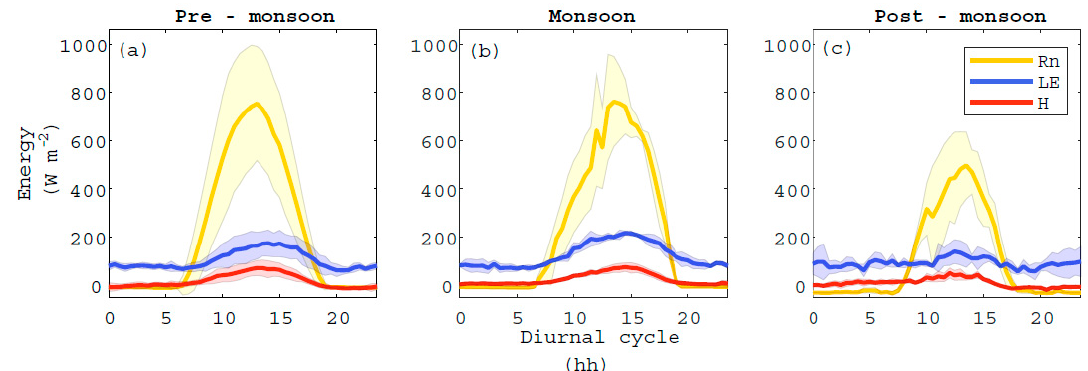
Figure 5. Diurnal cycle average and standard deviation (shaded area), for net radiation (Rn), latent heat (LE), and sensible heat (H) fluxes during the ( a ) pre-monsoon (January–June), ( b ) monsoon (July–August), and ( c ) post-monsoon (September–December).